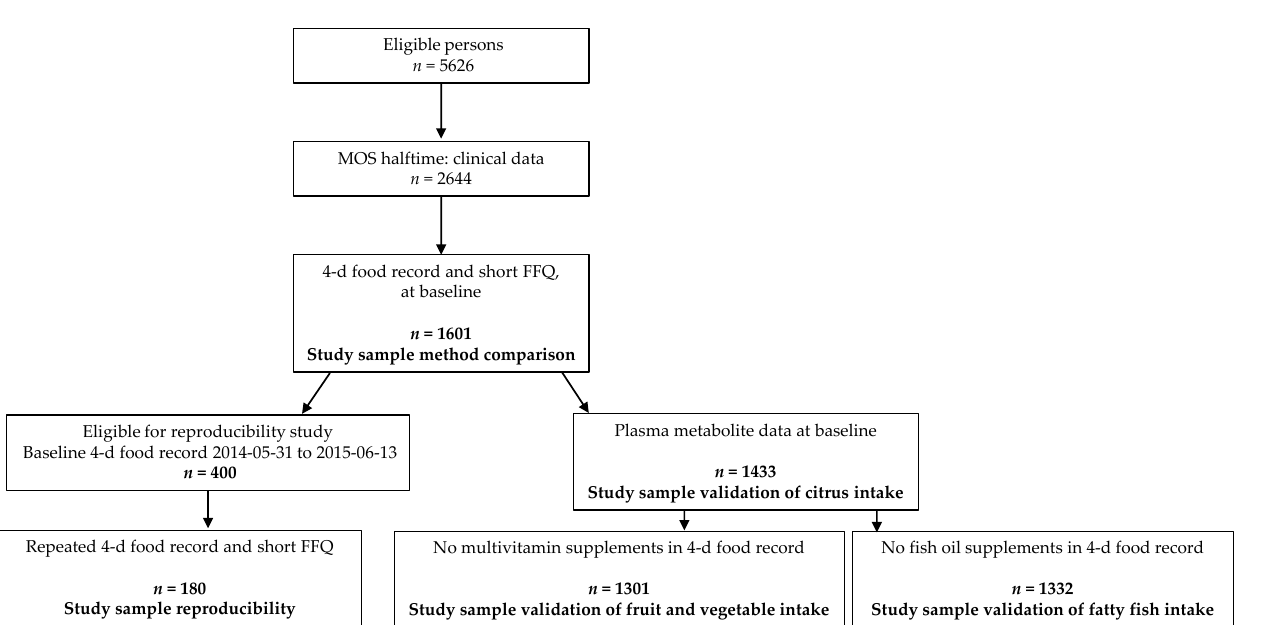
Figure 1. Flowchart of study samples in the Malmö Offspring Study until end of April